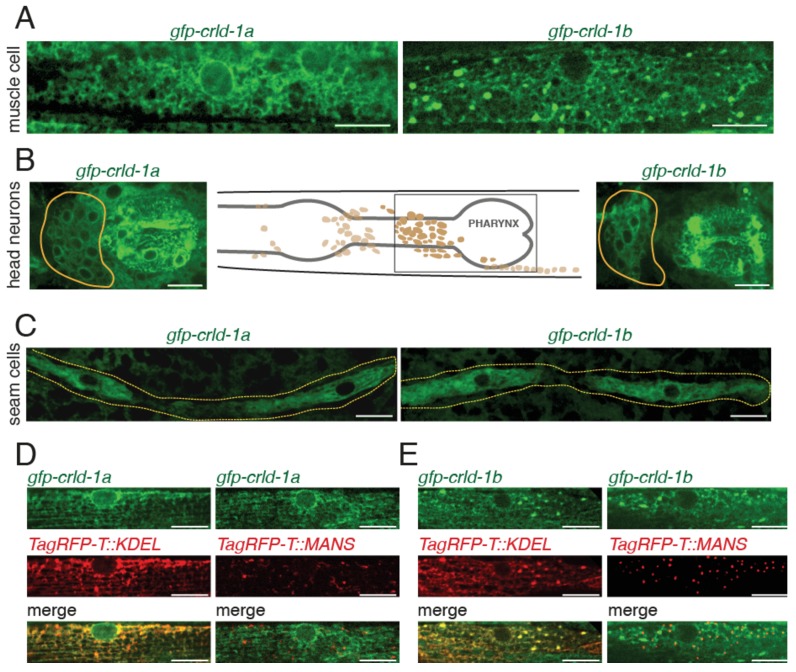
CRLD-1 is ubiquitously expressed and localizes in the ER of BWMs.(A) Distribution of GFP-CRLD-1A (left) and GFP-CRLD-1B (right) in muscle cells of gfp-crld-1 isoform-specific knock-in worms. (B) Localization of CRLD-1A (left) and CRLD-1B (right) in the pharynx and in the lateral ganglion (encircled in yellow). The middle panel shows a schematic representation of the locations of neurons and ganglia in the head, adapted from: http://www.wormatlas.org/ver1/MoW_built0.92/nervous_system.html. (C) Localization of CRLD-1A (left) and CRLD-1B (right) in the epithelial seam cells of gfp-crld-1 isoform-specific knock-in worms. Dashed lines, seam cell outlines. (D) Expression of the ER marker TagRFP-T::KDEL in gfp-crld-1a (left) and gfp-crld-1b (right) isoform-specific knock-in strains. TagRFP-T::KDEL displays a reticular pattern throughout the cytoplasm surrounding the nucleus that co-localizes with both CRLD-1A and CRLD-1B signals. (E) CRLD-1A and CRLD-1B from gfp-crld-1a (left) and gfp-crld-1b (right) knock-in animals do not co-localize with a Golgi-resident TagRFP-T-tagged Mannosidase II protein (MANS::TagRFP-T). In (D) and (E), the Pmyo-3 promoter was used for expression of both TagRFP-T::KDEL and MANS::TagRFP-T in body wall muscles. In all panels, scale bars equal 10 μm.